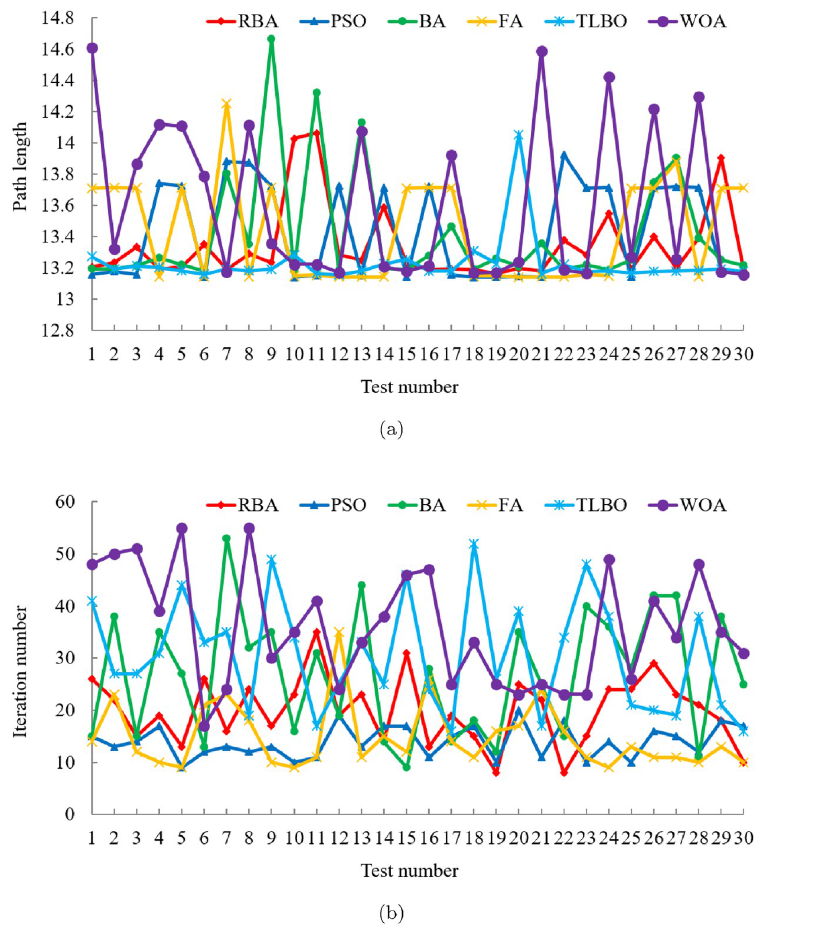
Fig 6. Experimental results of six algorithms in test case 2. (a) Path length. (b) Iteration number.